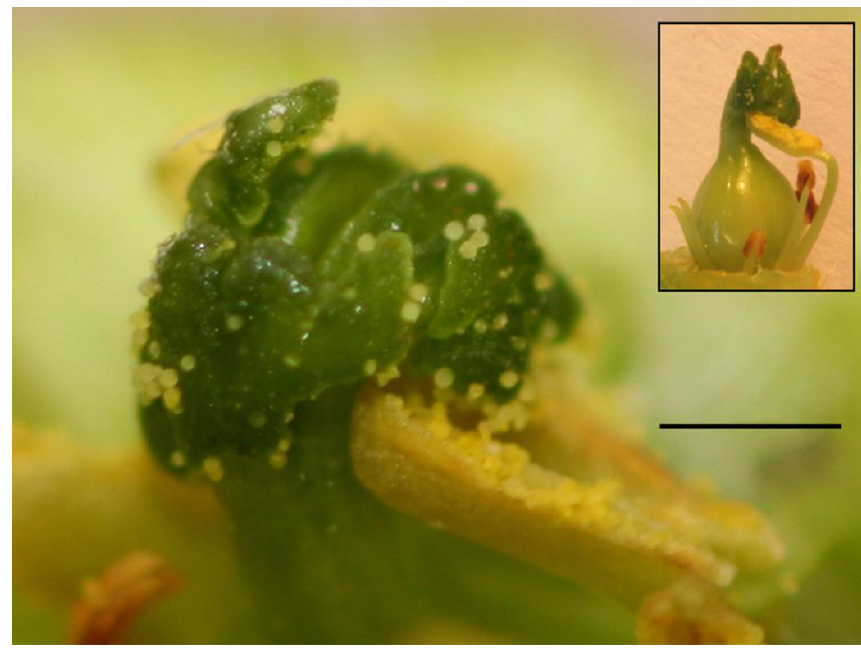
F IGURE 2. The stigma of a perfect flower bending over a fertile anther. Scale bar is 1